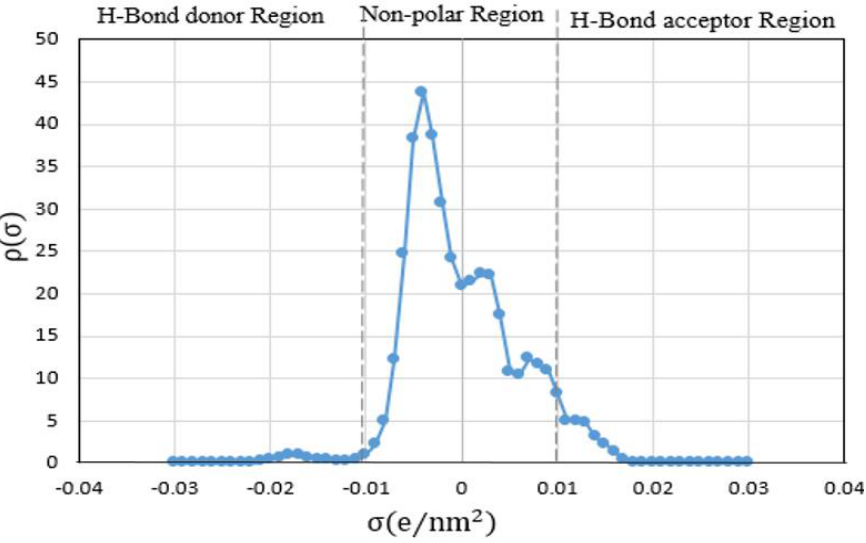
Figure 1. ( A ) EPA chemical structure and ( B ) sigma surface.